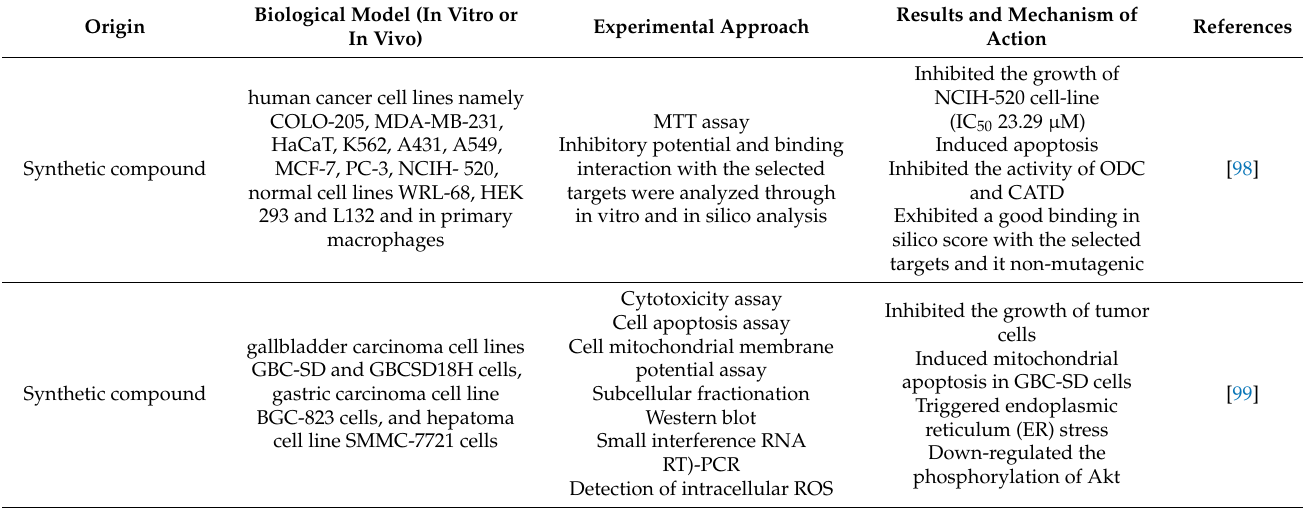
Table 4. Anticancer activity of